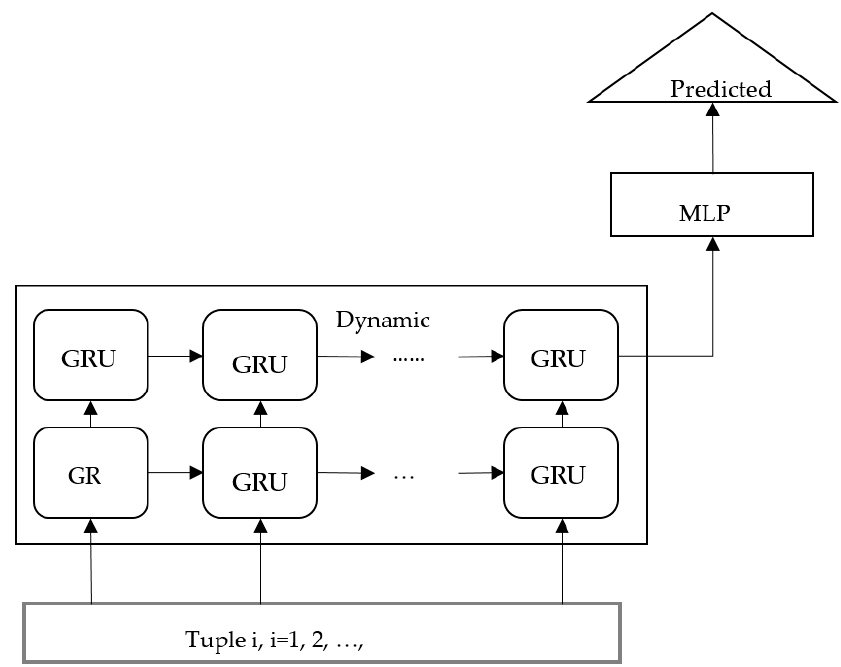
Figure 3. Detailed implementation of recurrent neural network (RNN) model.